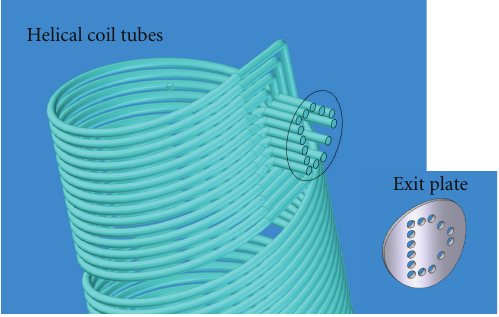
Figure 8: SPES3 SG tubes.